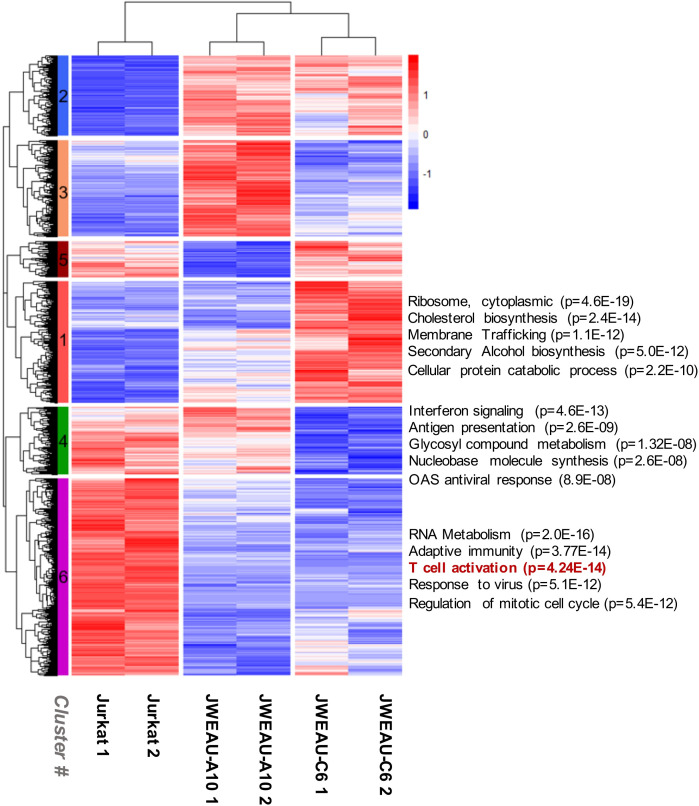
Transcriptomic analysis reveals extensive differences between TCR/CD3-inert and -responsive latently HIV-1 infected T cell clones.RNA-seq analysis was used to describe the genome-wide RNA expression signature of uninfected Jurkat T cells, the TCR/CD3 responsive JWEAU-A10 and the TCR/CD3-inert JWEAU-C6 T cells. For each T cell line, RNA-seq data were obtained for low and high cell density conditions. 7,151 genes with differential expression (likelihood ratio test, adjusted P-value < 0.01) across the three cell types were subjected to hierarchical clustering. Subtrees representing genes that were lowly or highly expressed throughout all three cells were automatically omitted through the selection criteria. Results for motif enrichment analysis for clusters #1, #4 and #6 are presented.